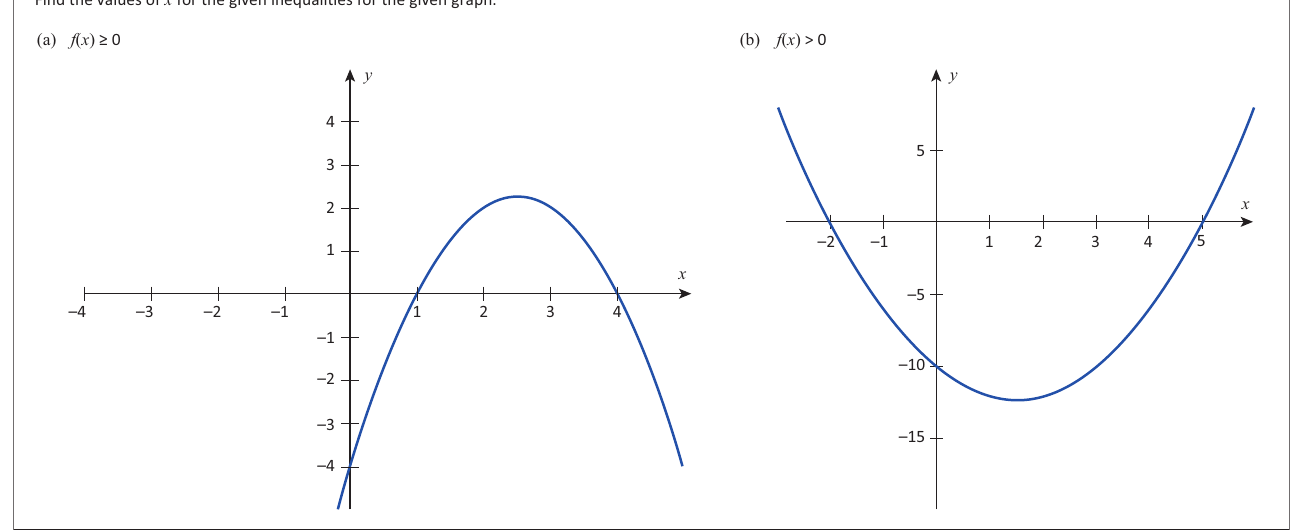
FIGURE 1: Task on quadratic inequalities when dealing with the real number system.